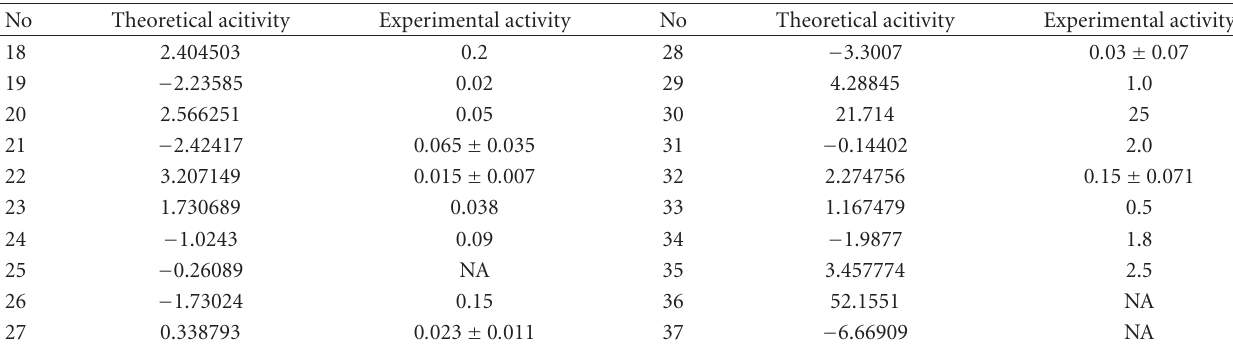
Table 4: Comparison of experimental and theoretical the activity by using the multiple regression analysis for compounds in Skeleton II. No Theoretical